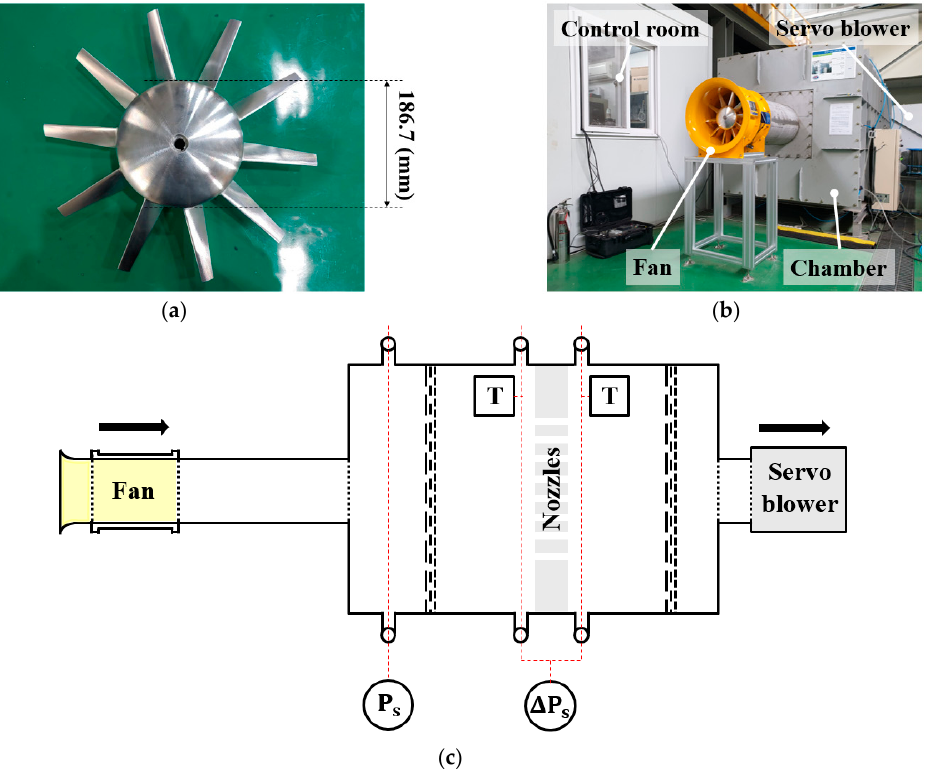
Figure 7. Experimental test set-up: ( a ) photograph of the small-scaled rotor; ( b ) photograph of the small-scaled model fan and test facility; ( c ) schematic diagram of test facility.